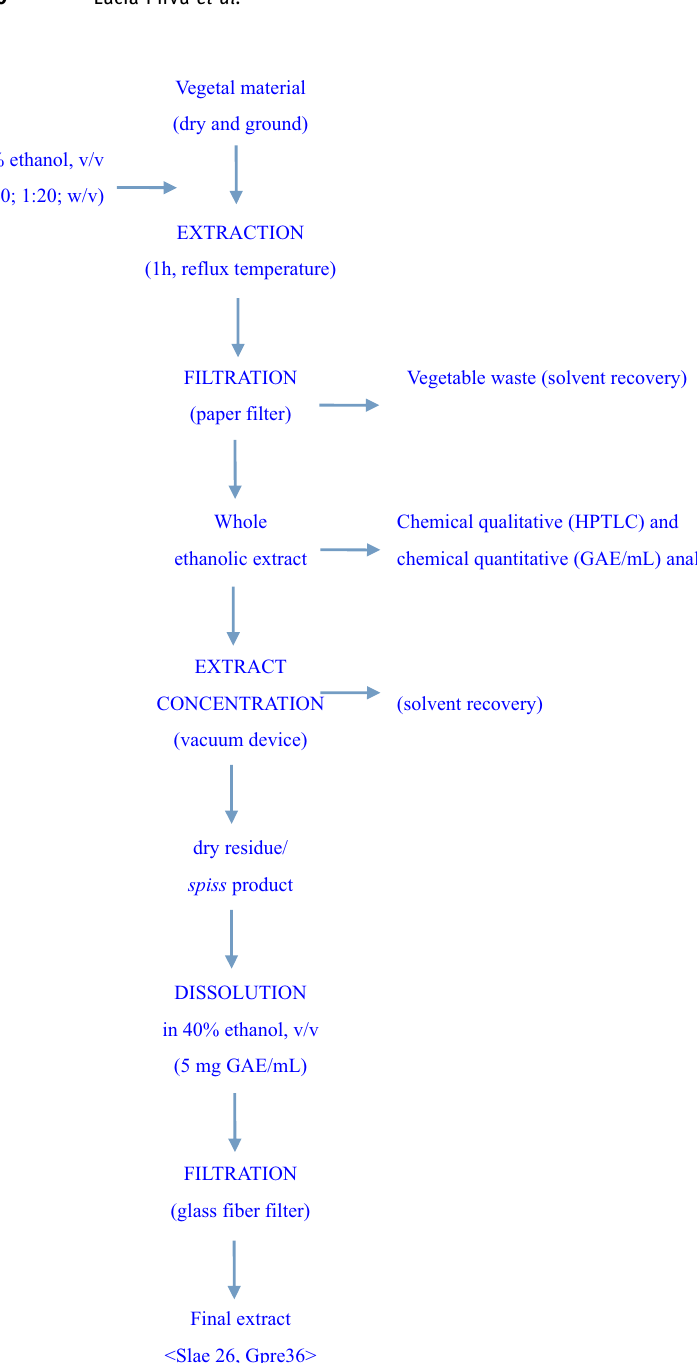
Figure 1: General method for the preparation of vegetal